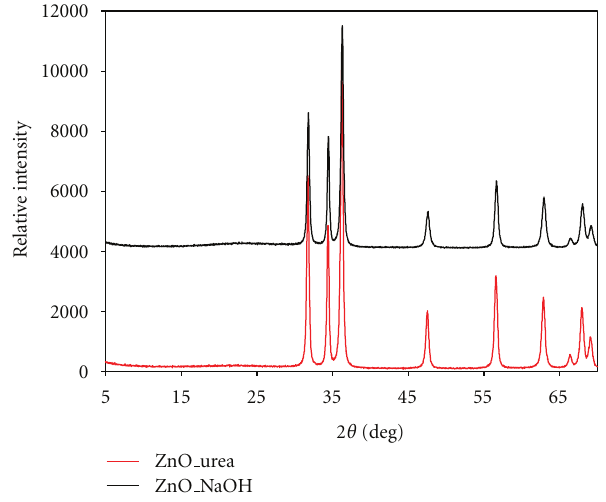
Figure 3: XRD pattern of ZnO samples.